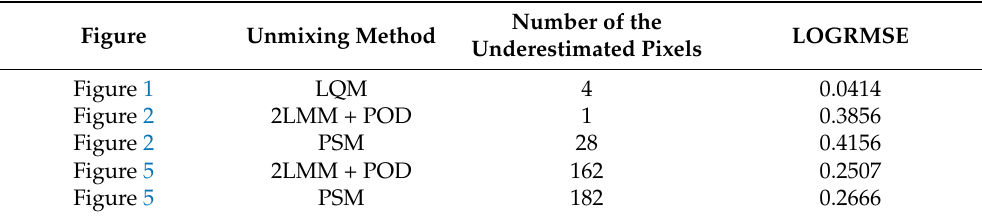
Table 3. Recalculated results of LOGRMSE after avoiding the underestimated pixels from corners of figures.